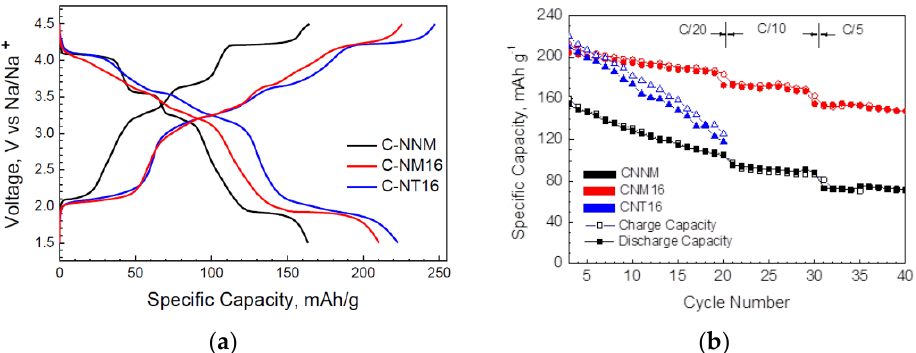
Figure 6. Charge–discharge curves after the 2nd cycle for CNNM, CNM16 and CNT16 in sodium- ion cells ( a ). Specific capacity, cycling stability and rate capability for CNNM, CNM16 and CNT16 in sodium-ion cells ( b